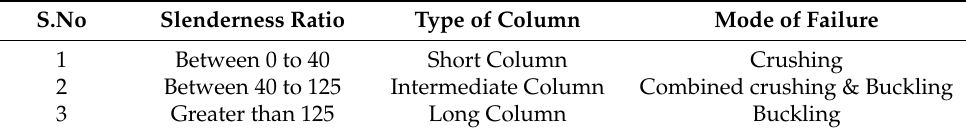
Table 1. Slenderness